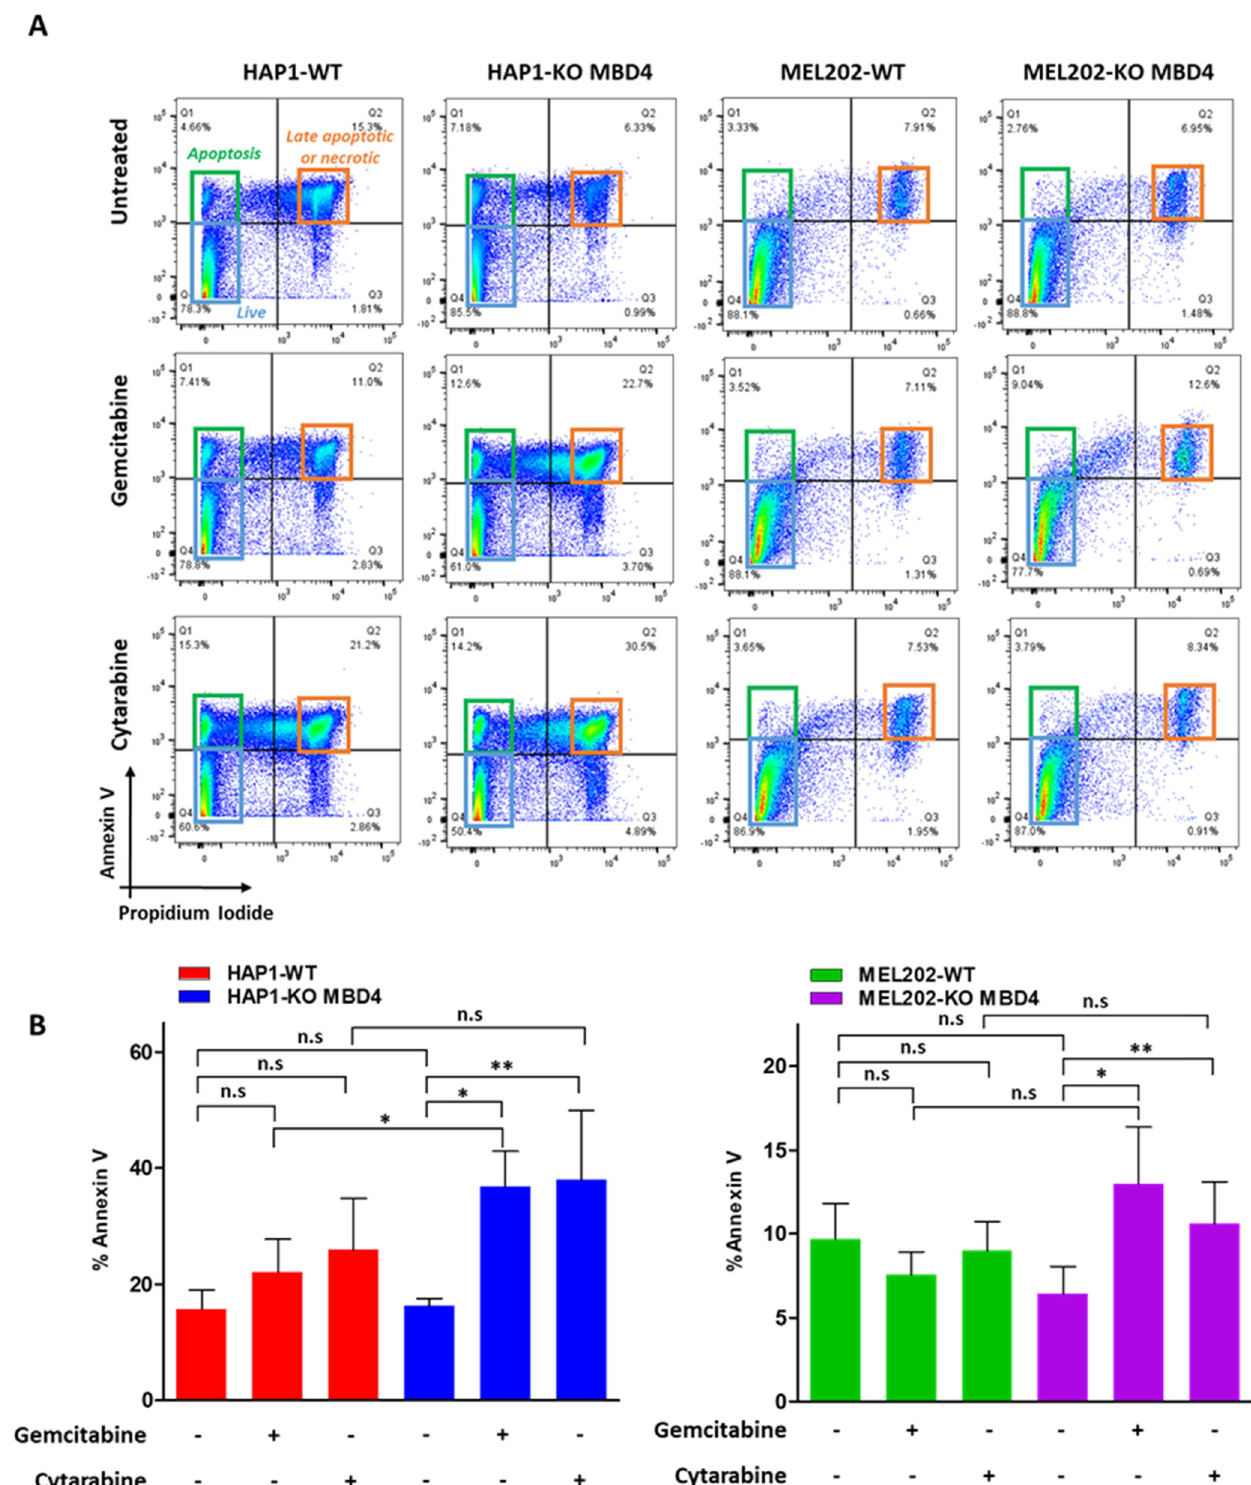
Fig. 3 Gemcitabine and cytarabine increase cell death of MBD4-de fi cient cell lines as compared with pro fi cient cell lines. A Analysis of the scatter plot. Annexin V/Propidium Iodide double-negative cells correspond to live cells (blue square), Annexin V positive/Propidium Iodide negative cells correspond to apoptotic cells (green square), and Annexin V/Propidium Iodide double-positive cells correspond to late apoptotic and necrotic cells or undetermined population (orange square). Scatter plots represent a representative experiment among three carried out independently. B Percentage of HAP1 and MEL202, MBD4-pro fi cient (red and green columns) and de fi cient (blue and violet columns) Annexin V positive cells from three independent assays (mean ± SD; n.s non-signi fi cant; * P < 0.05; ** P < 0.01; unpaired two-sided Student ’ s t